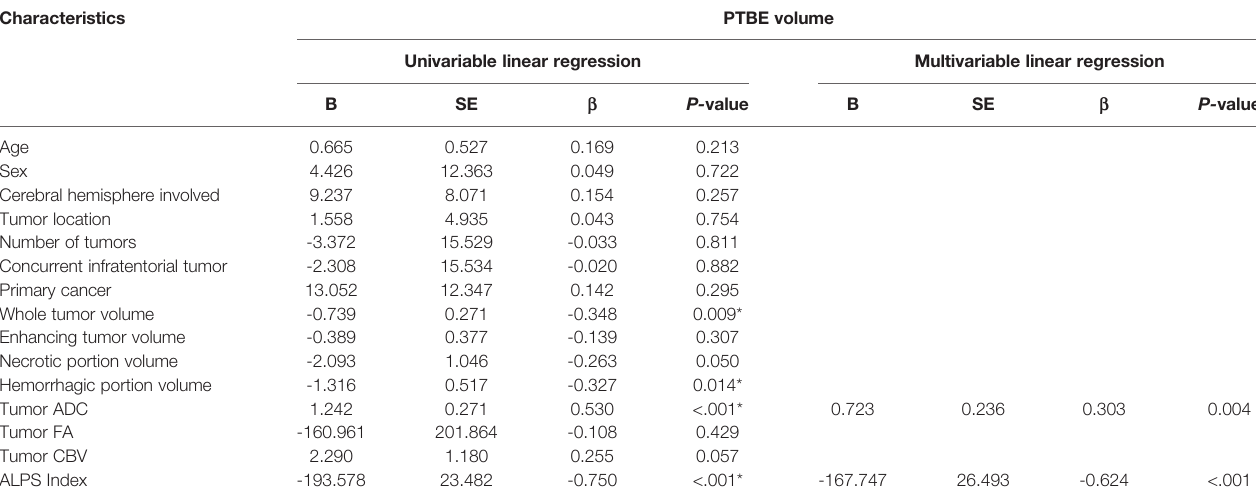
TABLE 3 | Univariable and multivariable linear regression analyses of factors associated with peritumoral brain edema (PTBE) volume. Characteristics